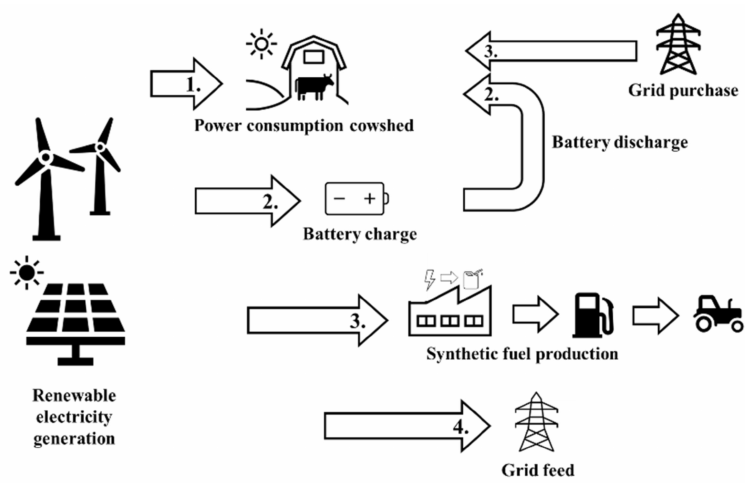
Figure 1. Scheme of a regenerative energy supply from self-power generation in the survey dairy